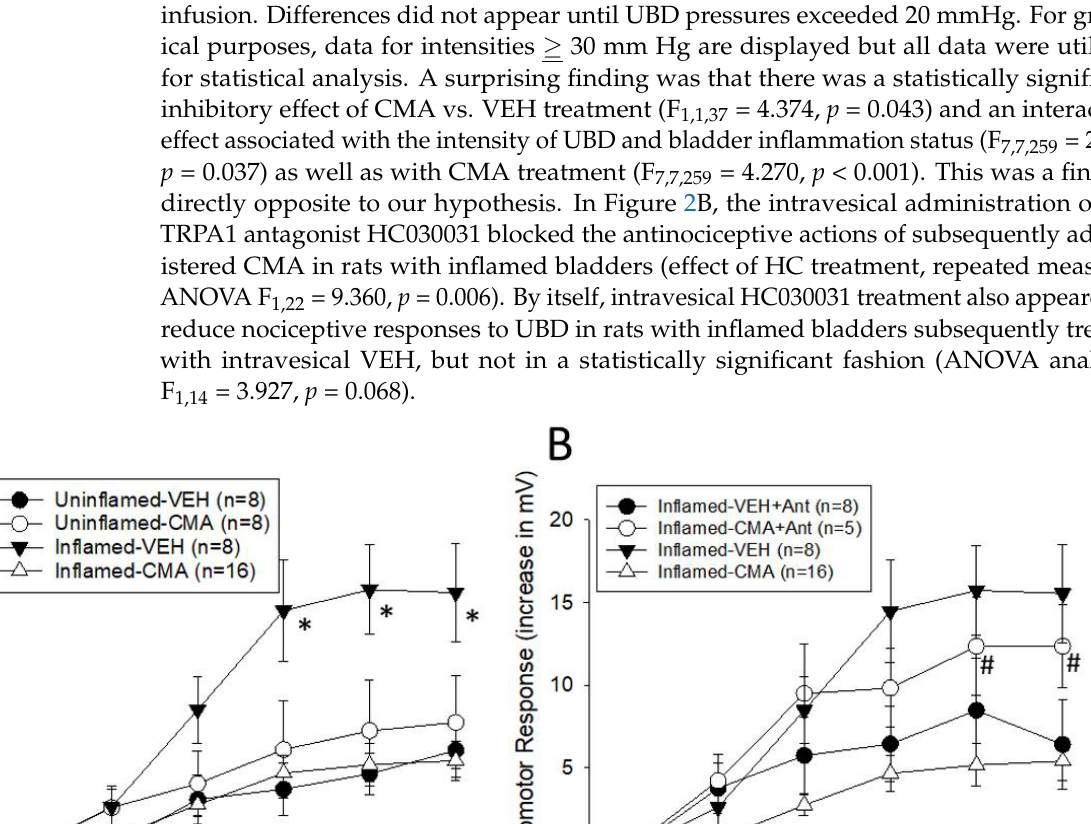
5 Figure 1. Response to intravesical infusion. Change in rectified EMG activity of superior oblique musculature when compared to baseline measures prior to drug infusion in rats with and without inflamed bladders. VEH indicates intravesical infusion of vehicle (mineral oil) whereas CMA indi-